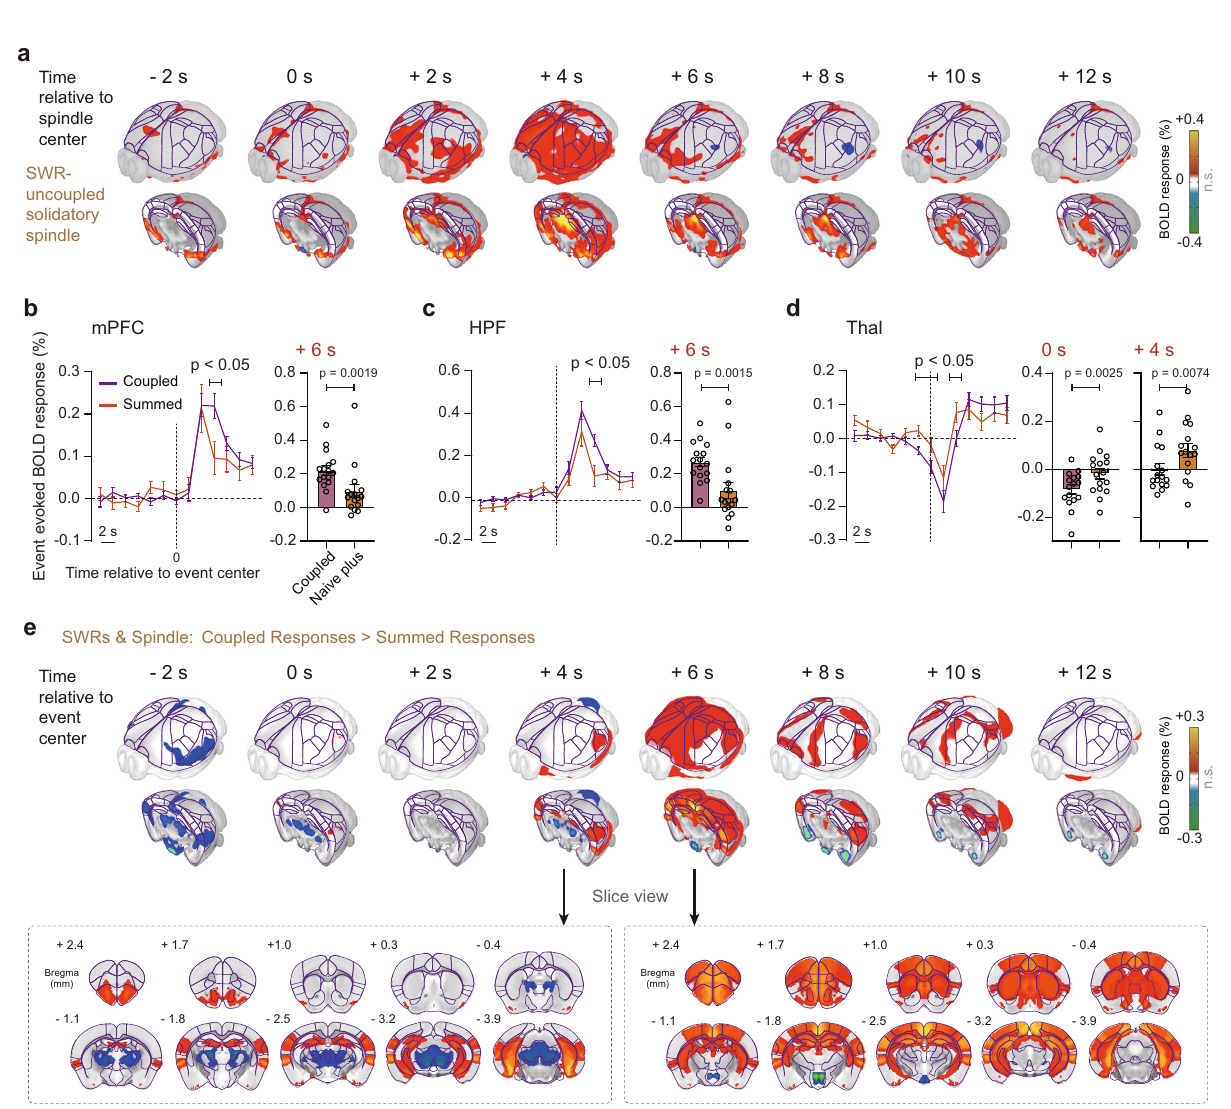
Fig. 7 | State dependent global spatiotemporal patterns of SWRs in AW and NREM states using neural-event-triggered (NET) fMRI. a SWR-triggered BOLD responses in AW (12732 epochs) and NREM (10953 epochs) states. The number of event epochs were counted under the sampling rate of 0.5Hz (fMRI repetition time) in the following analysis. Results in the axial view were shown in Supple- mentary Fig. 17, 18. b Major brain divisions on 3D surface viewing as in ( a ). Abbreviations of ROIs were listed in Supplementary Data 1. c , d Signi fi cant differ- ence of SWR-triggered BOLDresponses in mPFCbetween AW and NREMstates ( c ) and its corresponding electrophysiological correlates ( d ). Gray lines (or shadows), mean (+/ − SEM.) correlation. Sample size: n =16 sessions. e Overlap of SWRs and spindle events in NREM state. f Spindle-uncoupled (4682 epochs) and